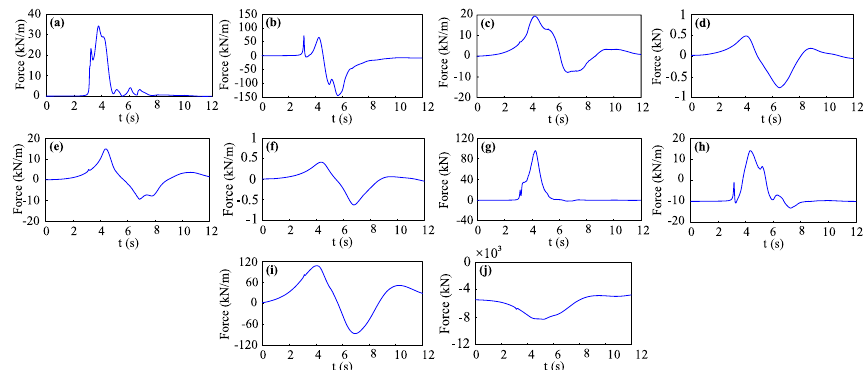
Fig. 6 Tsunami force time histories of various bridge components under D refer to the loading direction in the global coordinate system): a deck-Y, b deck-Z, c pier P1-Y, d pier P1-Z, e pier P3-Y, f pier P3-Z, g cap beam-Y, h cap beam-Z, i pile cap-Y and j pile